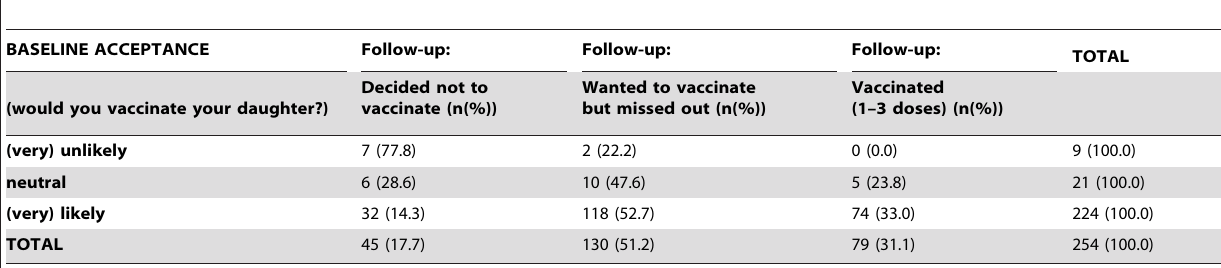
Table 4. Baseline acceptance and subsequent decisions regarding uptake of the HPV vaccine.